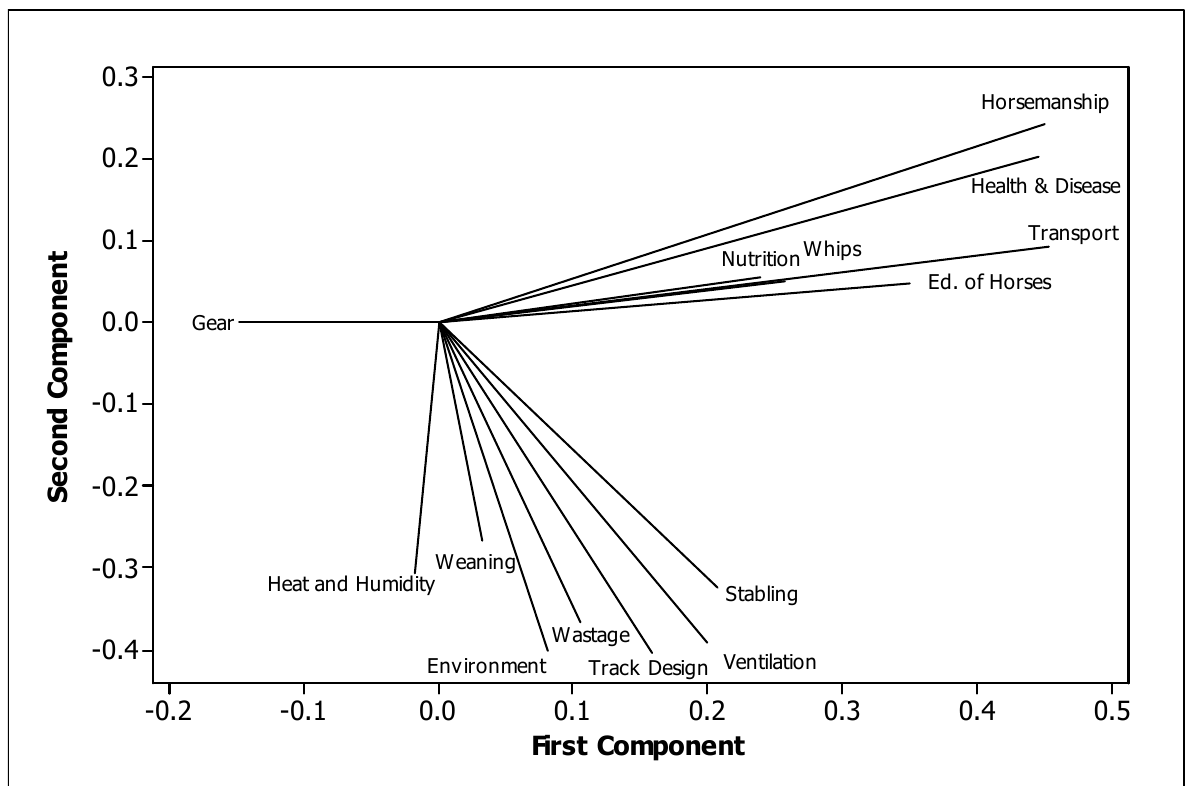
Figure 7. Relationship between first and second principal components for TBRWI issues .